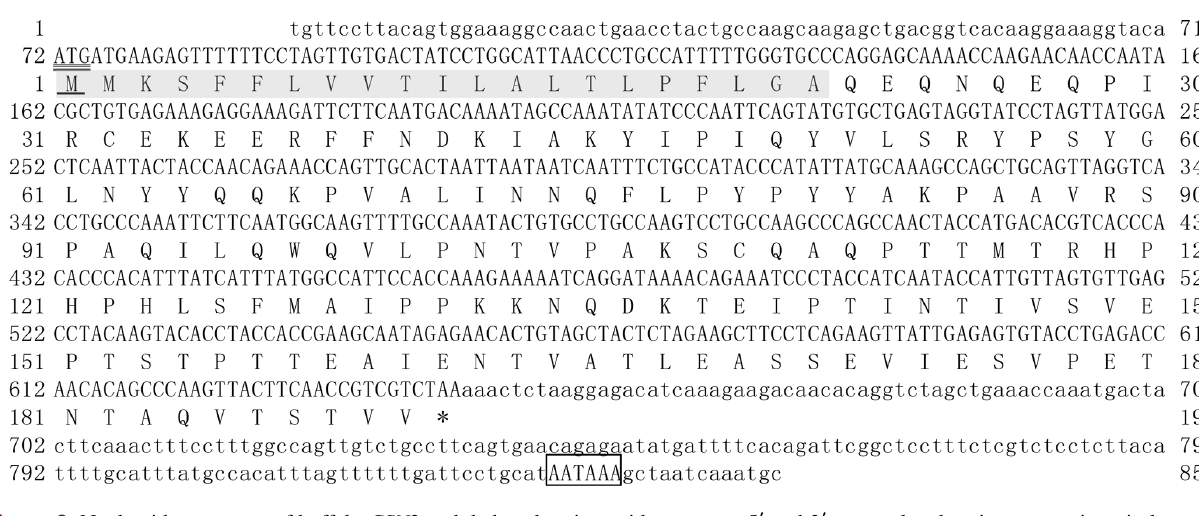
Figure 2. Nucleotide sequence of buffalo CSN 3 and deduced amino acid sequence; 5 (cid:48) and 3 (cid:48) -untranslated regions are written in lowercase and ORF is in uppercase. The predicted protein sequence is shown immediately below the nucleotide sequence. The start codon is double underlined and its amino acid is underlined. The signal sequence is shaded. The stop codon is indicated by an asterisk ( ∗ ). The polyadenylation signal is boxed. Table 2. Modification sites of the κ -CN mature peptide in buffalo and